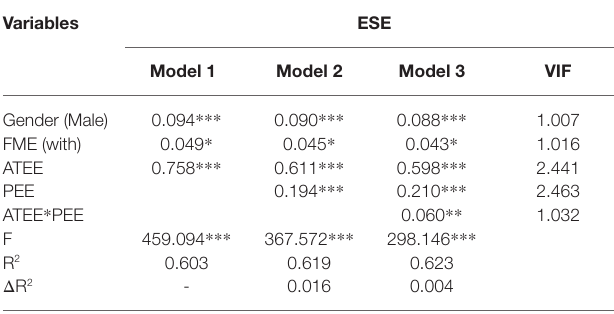
TABLE 3 | Descriptive information of the variables in the male and female groups. Variables Gender